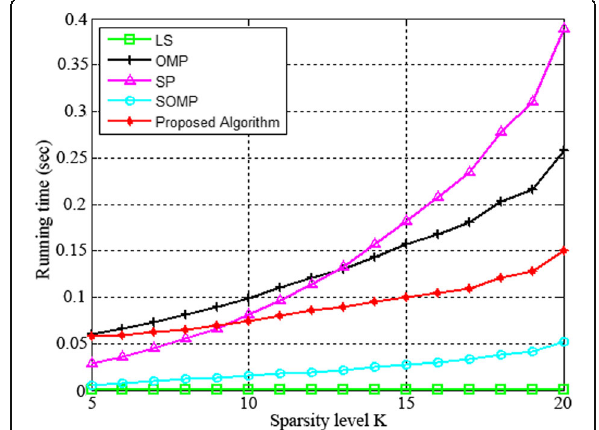
Fig. 5 CPU running time with different K sparse